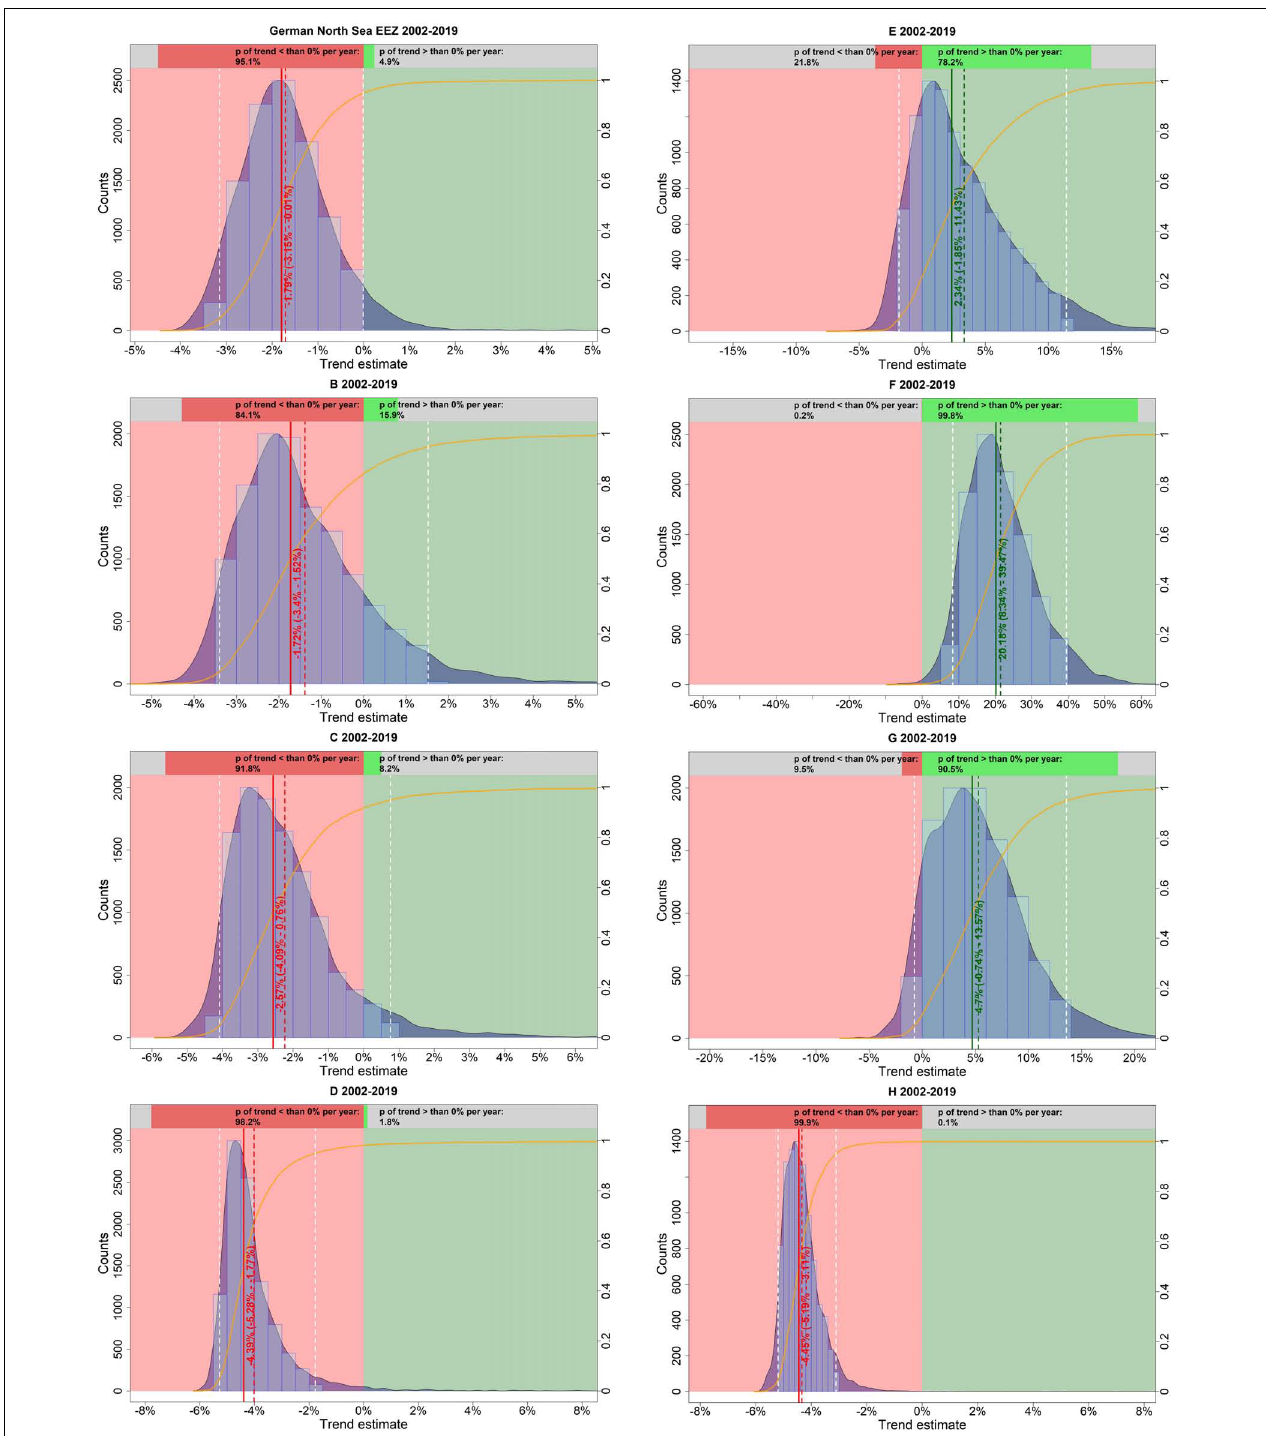
FIGURE 6 | Estimated trends in harbor porpoise abundance in the German North Sea EEZ (but excluding Dogger Bank) and in each strata (B–H) separately in summer, between 2002 and 2019. The light blue histogram and the blue shaded density curve show the distribution of the trend estimates (relative change in abundance) between 2002 and 2019 ( x -axis); the median is indicated by the solid red vertical line. The mean is shown by the vertical red dashed line, while the white dashed lines represent the upper and lower 95% credibility intervals of the trend estimate. The red colored area corresponds to an area with a negative trend, whereas the green colored area represents a positive trend. The orange solid line illustrates the empirical cumulative distribution function of the trend estimates, giving the probability of a trend estimate at a specified value (e.g., 0%). The upper bar chart hence indicates how likely it is that the trend is either negative (i.e., p < 0%; red) or positive (i.e., p > 0%;